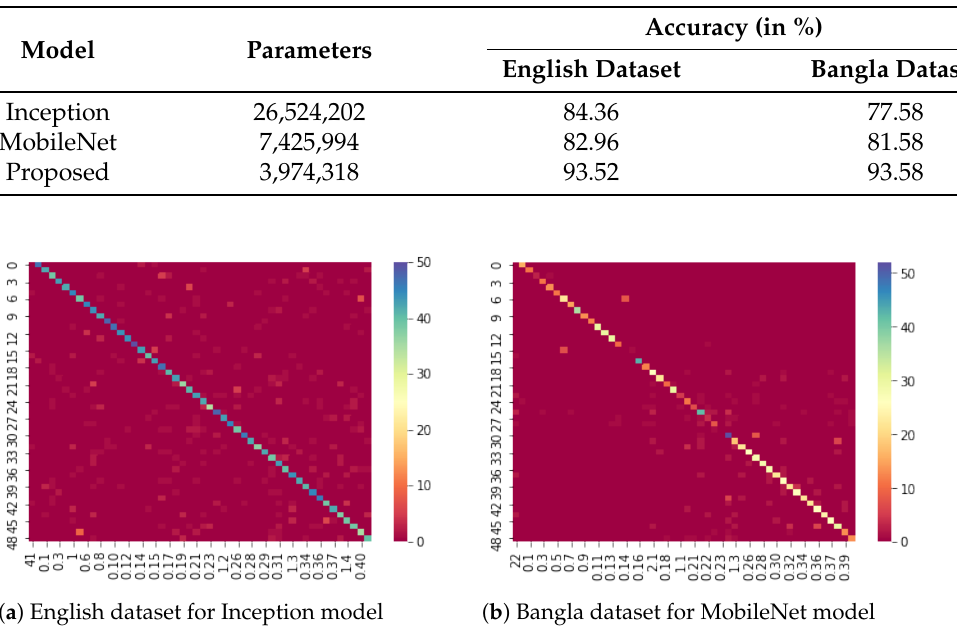
Figure 14. The Heat map obtained on the Bangla dataset and English datasets. The heat maps illustrate the model in which the datasets obtained maximum accuracies (for the English dataset it was the Inception model whereas for the Bangla dataset it was the MobileNet